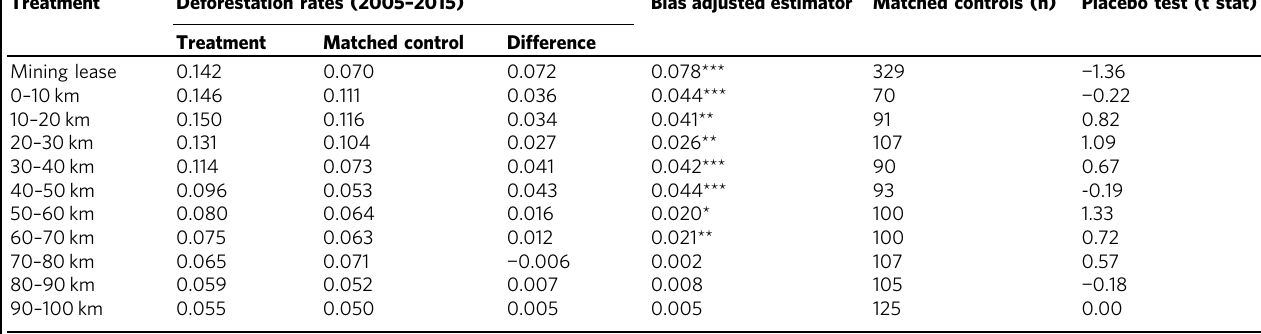
Table 2 Deforestation rates within treatments and their matched controls